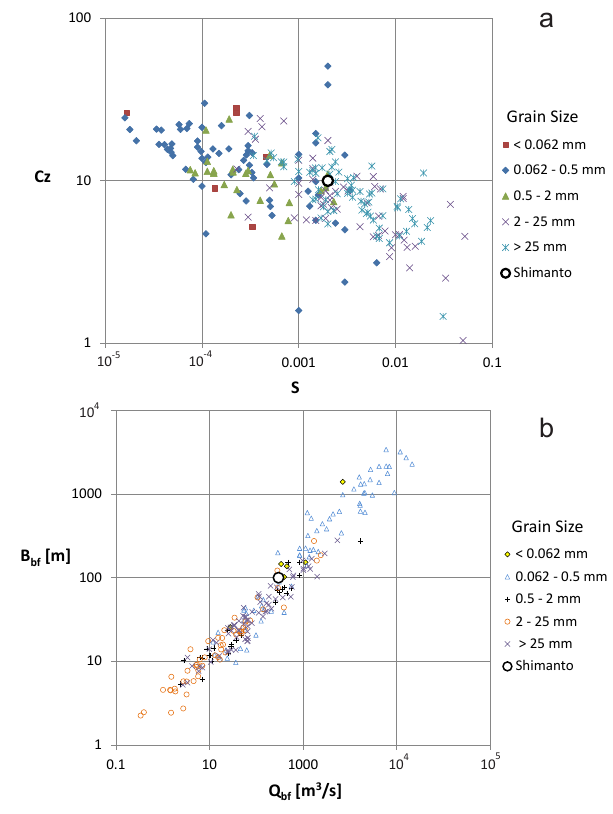
Figure 8. (a) Chézy resistance coefficient Cz plotted against bed slope S for alluvial rivers. Also included are estimated values for the Shimanto River, Japan. (b) Bankfull width B bf versus bankfull discharge Q bf for alluvial rivers. Also included are estimates for bank-to-bank width and characteristic flood discharge in the Shi- manto River, Japan. The ranges for characteristic bed material size of the alluvial rivers are denoted in the